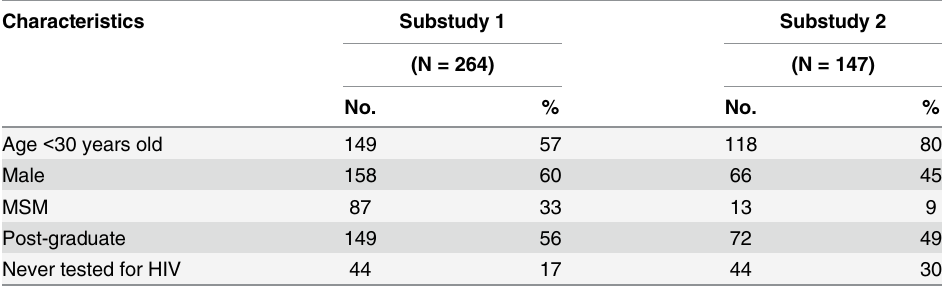
Table 3. Demographic characteristics of the study